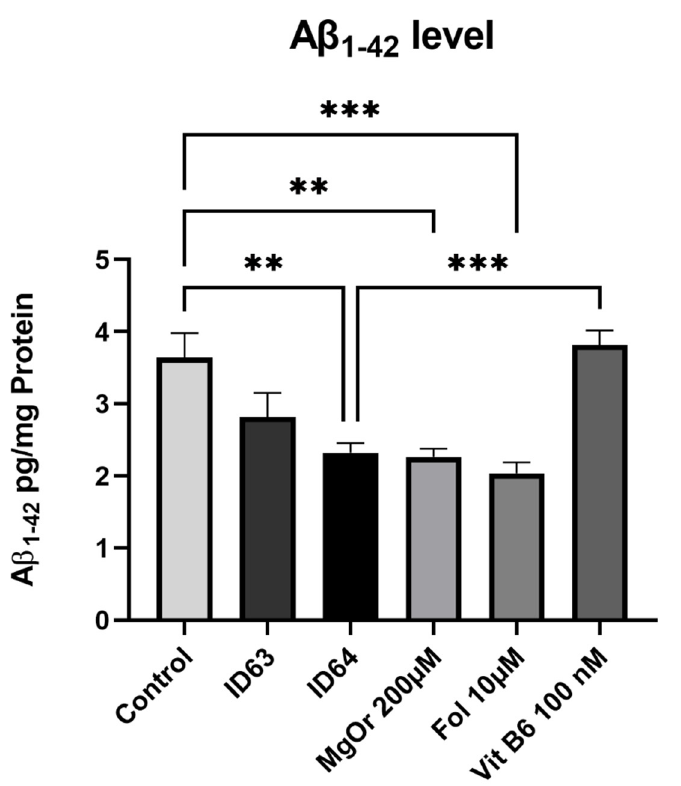
Figure 2. Effect of ID63 and ID64 in SH-SY5Y 695 cells compared to the control or their single substances on the A β 1–42 level after 24 h incubation. N = 6. A β 1–42 levels were adjusted to the protein content. Significance was determined by Student’s unpaired t -test and one-way ANOVA. ** p < 0.01 and *** p < 0.001. Data are displayed as the mean ± SEM. ID63 = 200 µ M MgOr and 10 µ M Fol; ID64 = 200 µ M MgOr, 10 µ M Fol and 100 nM Vit B6.